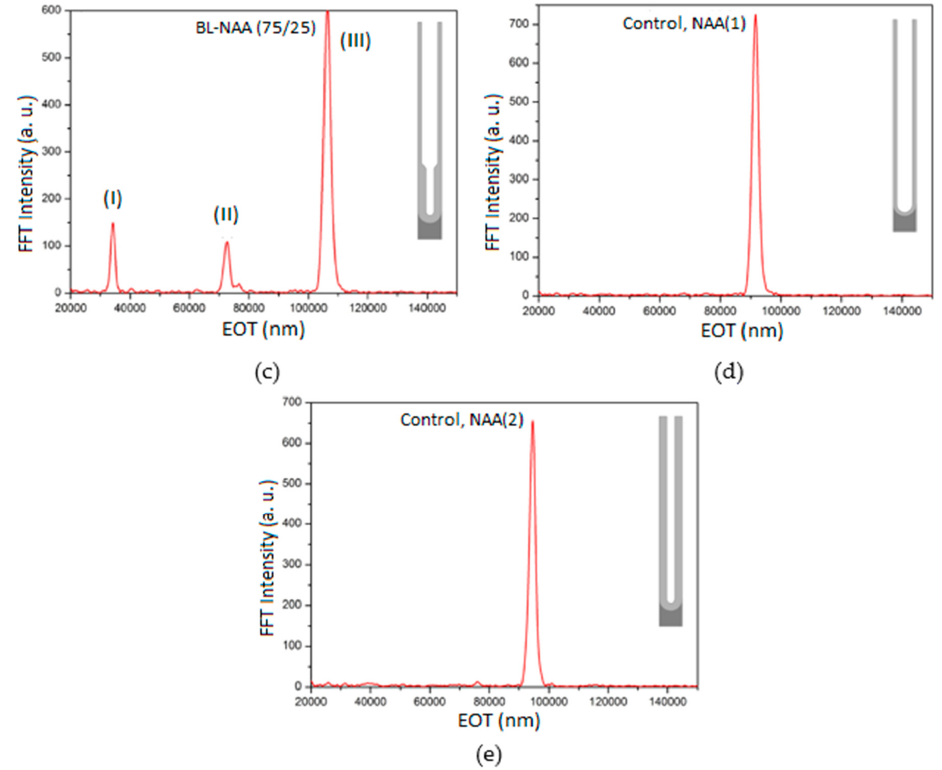
Figure 3, Comparison of FFT spectra of BL-NAAFs and NAAs with single layer and bilayer of nanoporous alumina structure. ( a ) Bi-layer structured of BL-NAA (25/75) produced during (Step1 = 20